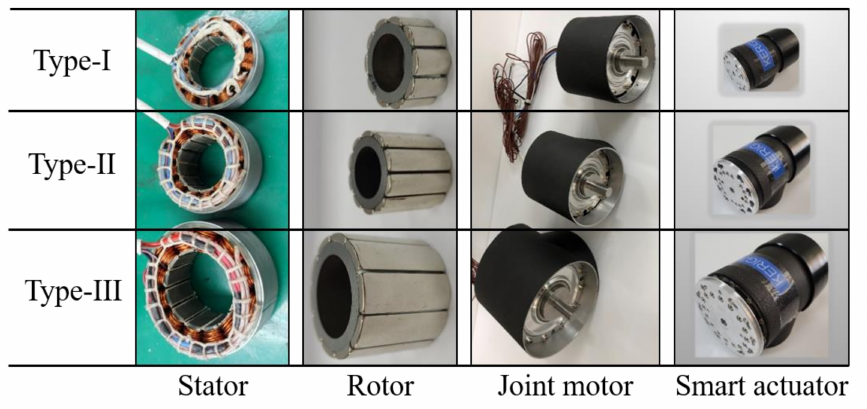
Figure 12. Three types of joint motors and smart